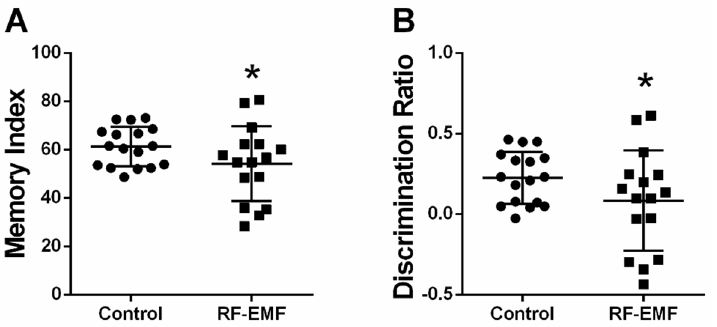
Figure 8. Novel object recognition test in RF-EMF-exposed early postnatal mice. Mice were exposed to 1850 MHz RF-EMF at a SAR of 4.0 W/kg for 5 h per day for 4 weeks (from P1 to P28). The memory index was decreased in RF-EMF-exposed mice (control n = 17 mice, RF-EMF n = 16 mice). The memory index was calculated by measuring interaction time with the novel object ( A ). The discrimination ratio was calculated by measuring the exploration time for the novel object compared to the old object as a proportion of the total exploration time ( B ). Data are expressed as means ± SD. Statistical significance was evaluated using the Student’s t -test. * p < 0.05.